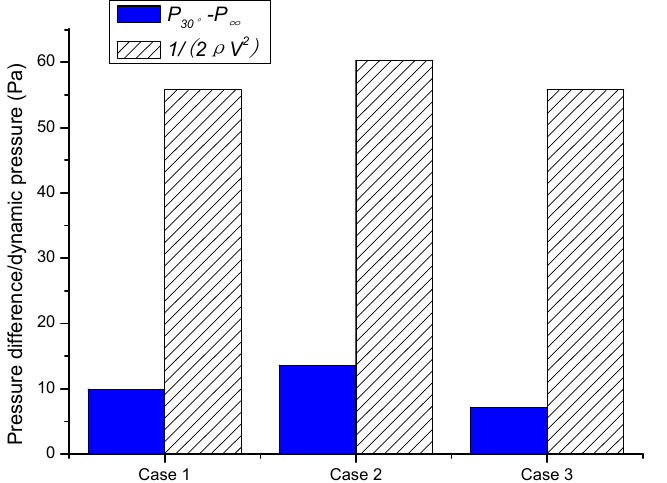
Figure 7. Comparison between the pressure differences and the dynamic pressures for different cases.